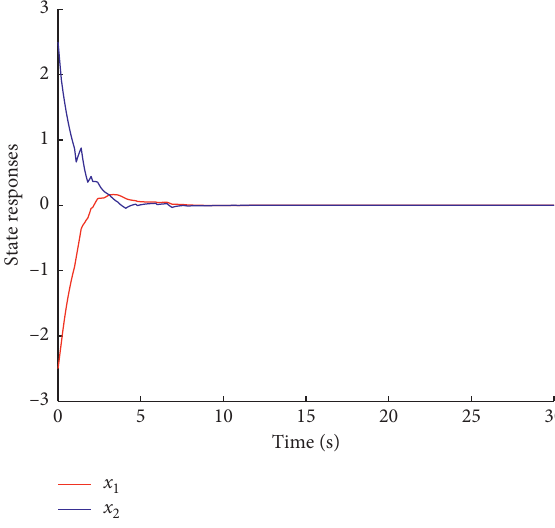
Figure 5: The state response in Case 2.